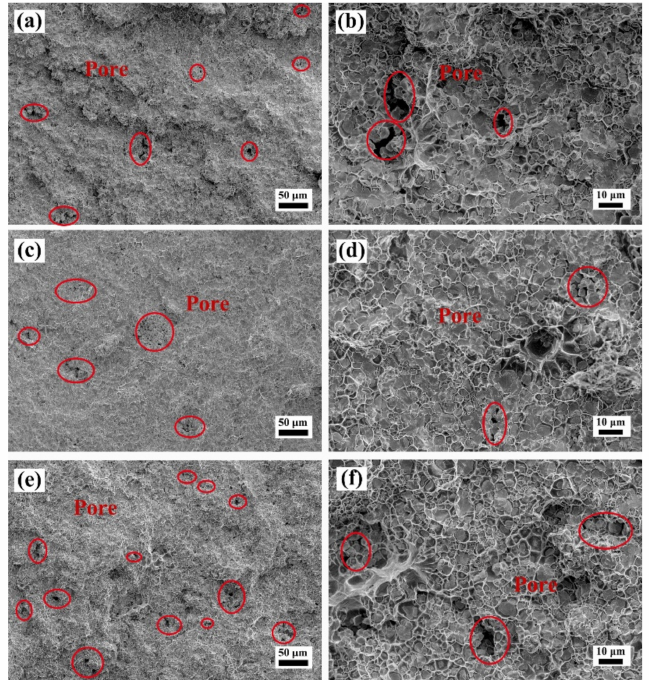
Figure 9. SEM images of the fracture surface of the ( a , b ) WY–050–10Cu, ( c , d ) WY–050–15Cu, and ( e , f ) WY–050–20Cu composites after bending tests.